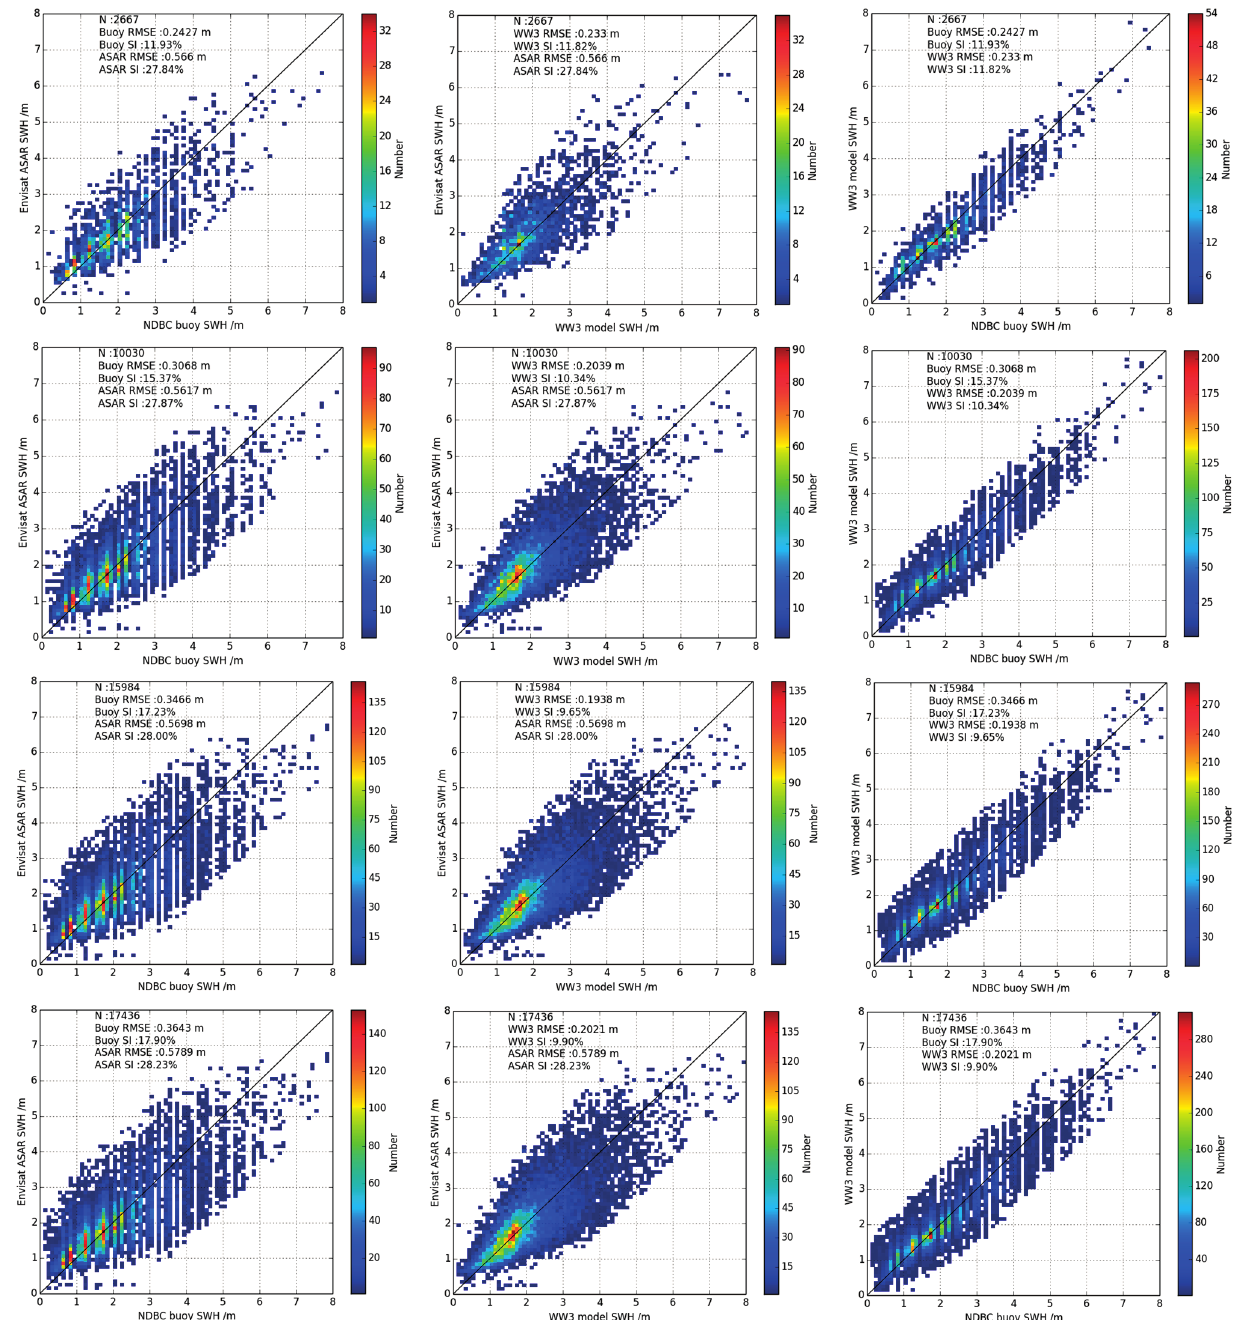
Figure 5. Scatter plots of the comparison results with all the 152 buoys, for Envisat ASAR vs. NDBC buoys ( the left panels ), Envisat ASAR vs. ww3 model ( the middle panels ), and ww3 model vs. NDBC buoys ( the right panels ). The collocation distances between ASAR and buoy in the plots from upper to bottom panels are 50 km, 100 km, 150 km and 200 km, respectively. The numbers in the color bar represent the number of collocated data points per 0.1 m histogram